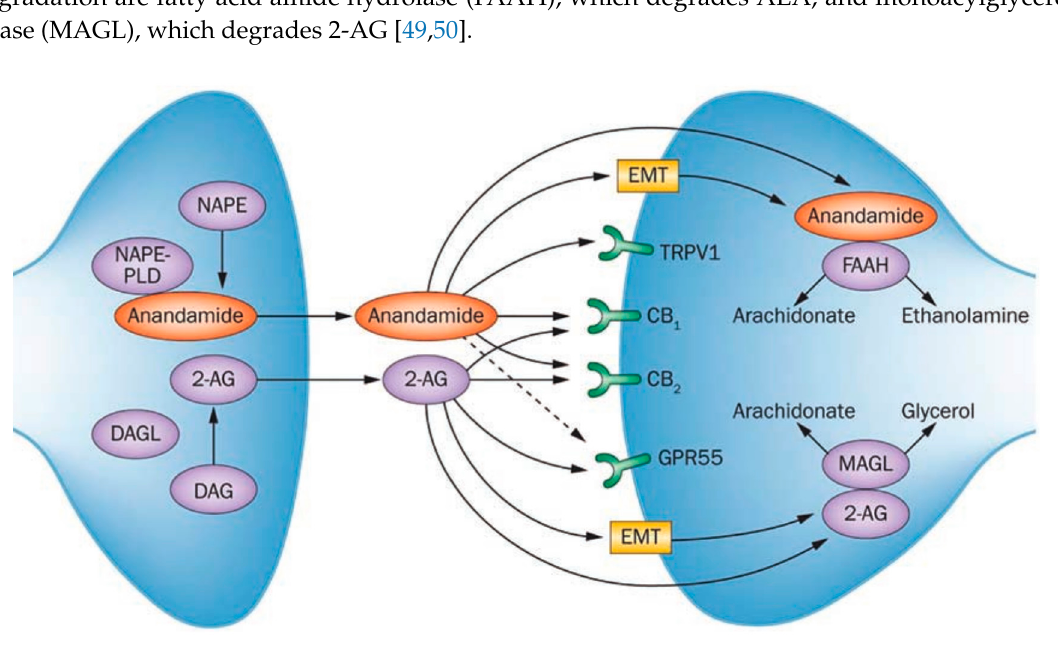
Figure 1. Summary of the endocannabinoid system; highlights key endocannabinoids, cannabinoid receptors, and synthesis/degradative enzymes. NAPE: N